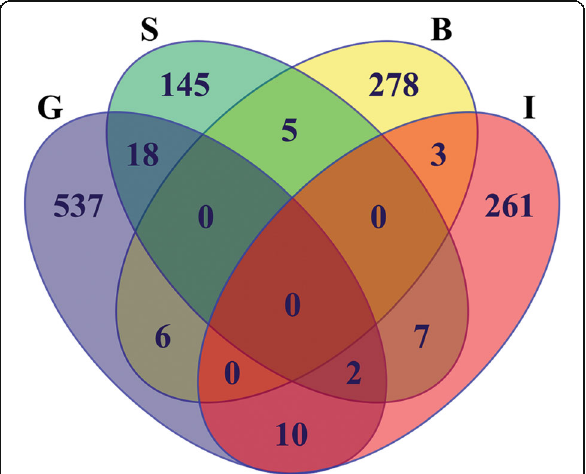
Fig. 3 Venn diagram showing overlapped cold-stress deregulated genes in four anther datasets. Up- and downregulated genes from this work (G), (Suzuki et al. 2015) (S), (Bai et al. 2015) (B), and (Ishiguro et al. 2014) (I) were compared. Notice there are only 2 genes commonly deregulated in more than two